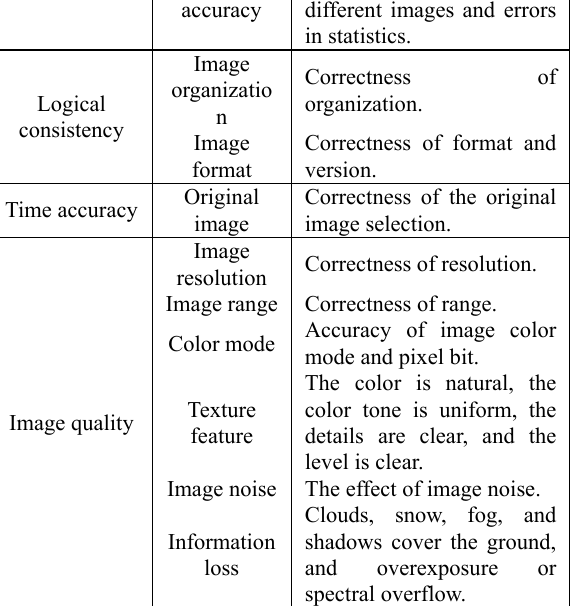
Table 1. Quality characteristics and inspection contents